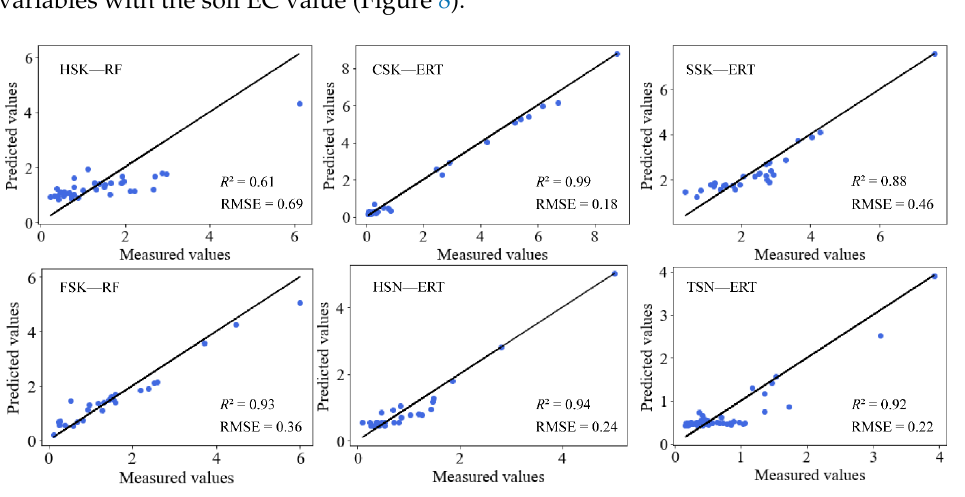
Figure 8. Scatter plots of the measured EC values and the best model-predicted values for different saline soil